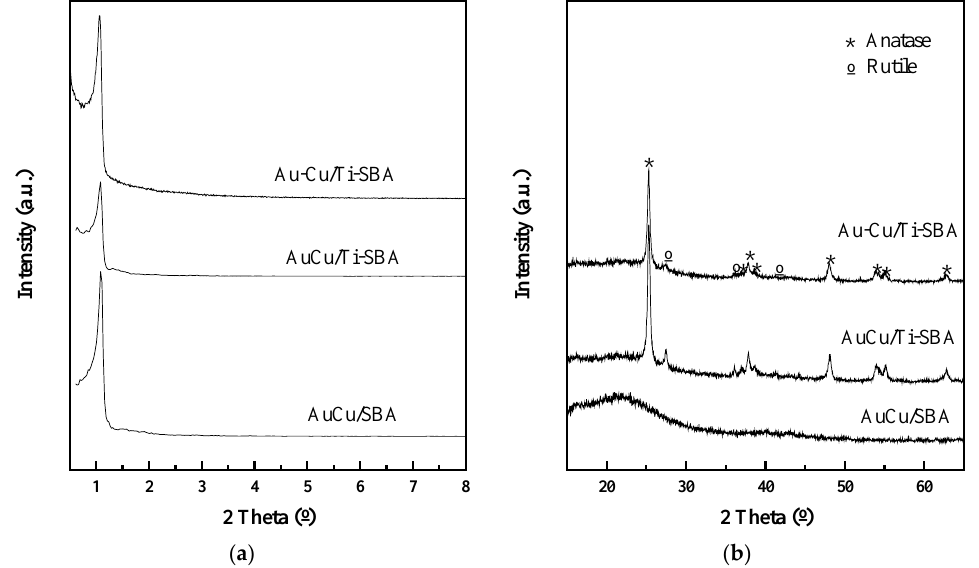
Figure 5. ( a ) Low-angle and ( b ) high-angle X-ray diffractograms (XRD) for the as-prepared samples.